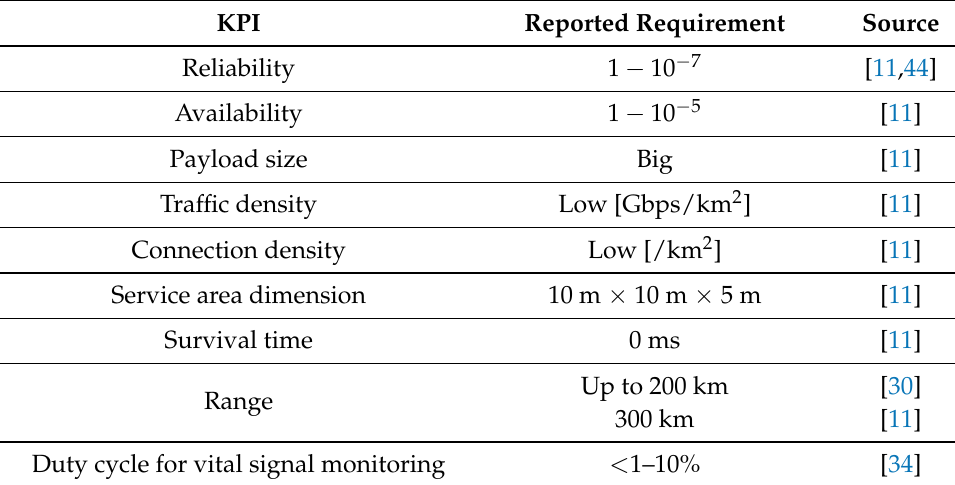
Table A5. Other requirements for